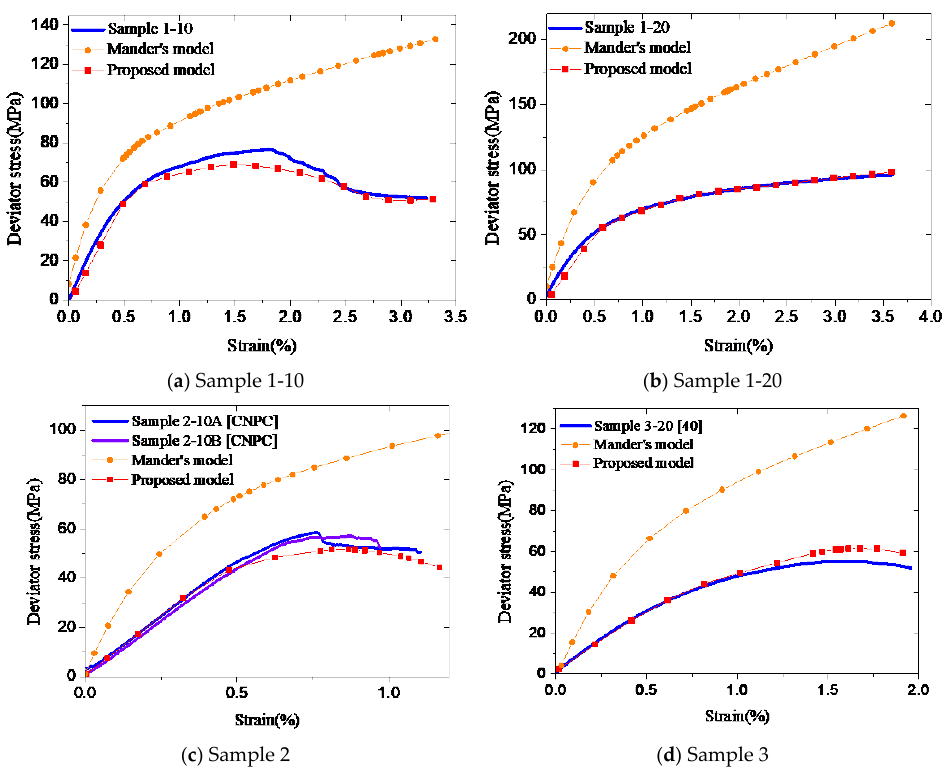
Figure 8. Comparison of numerical calculation with experiment results ( a-d ).